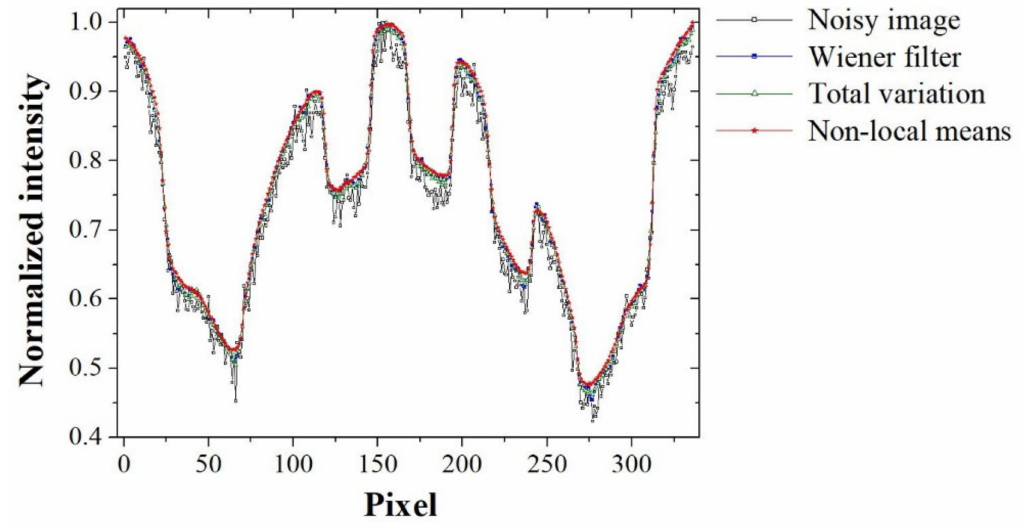
Figure 6. Intensity profile (using line AB in Figure 5) in relation with denoising methods applied to the acquired image of the aluminum die-casting